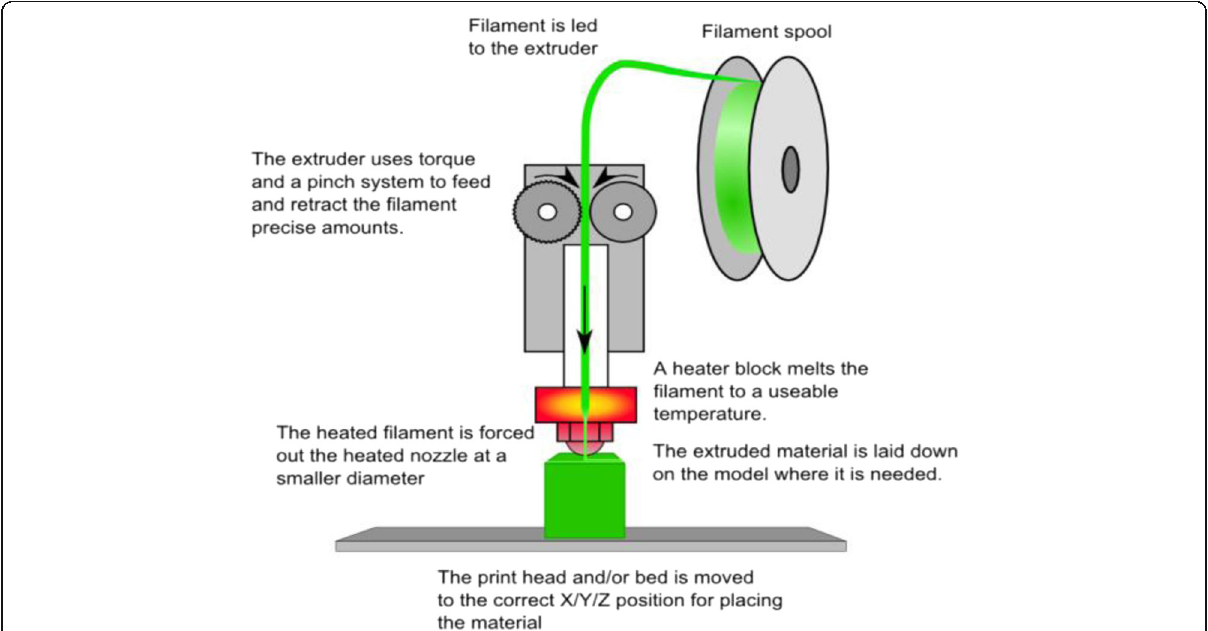
Fig. 3 Schematic representation of fused deposition modeling, reused from free copyright website RapRap